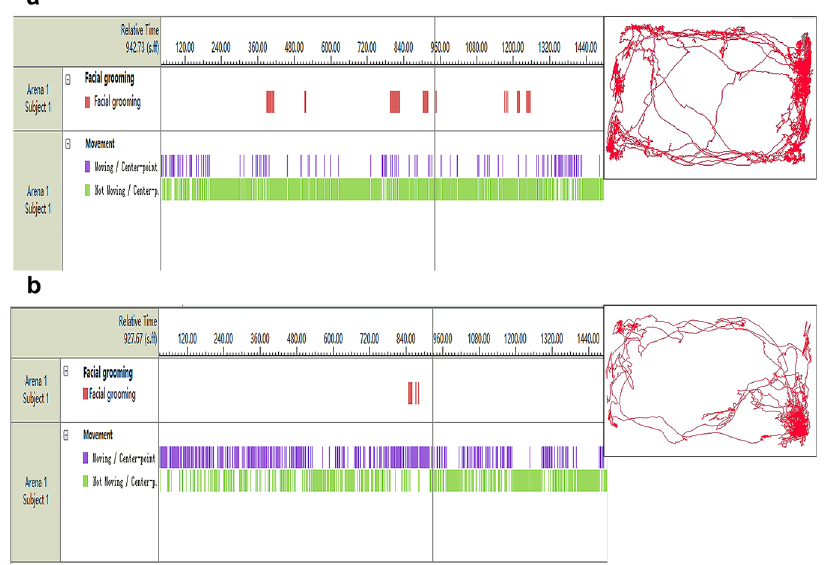
Figure 2. Tracking of rat activity using a video tracking system (EthoVision XT 35 ). Rat activity trajectories after infusion. ( a ) An animal’s path after saline infusion. ( b ) After IS infusion, the rats exhibited greater face- grooming and quiescent behavior times. The panels on the left illustrate the time and duration of each behavior. The red bars represent face-grooming activity. The blue bars illustrate moving activity. The green lines show quiescent behavior. The square area represents the open arena, and the representative path of one rat during the 30 min after infusion is shown in red. IS, inflammatory soup.